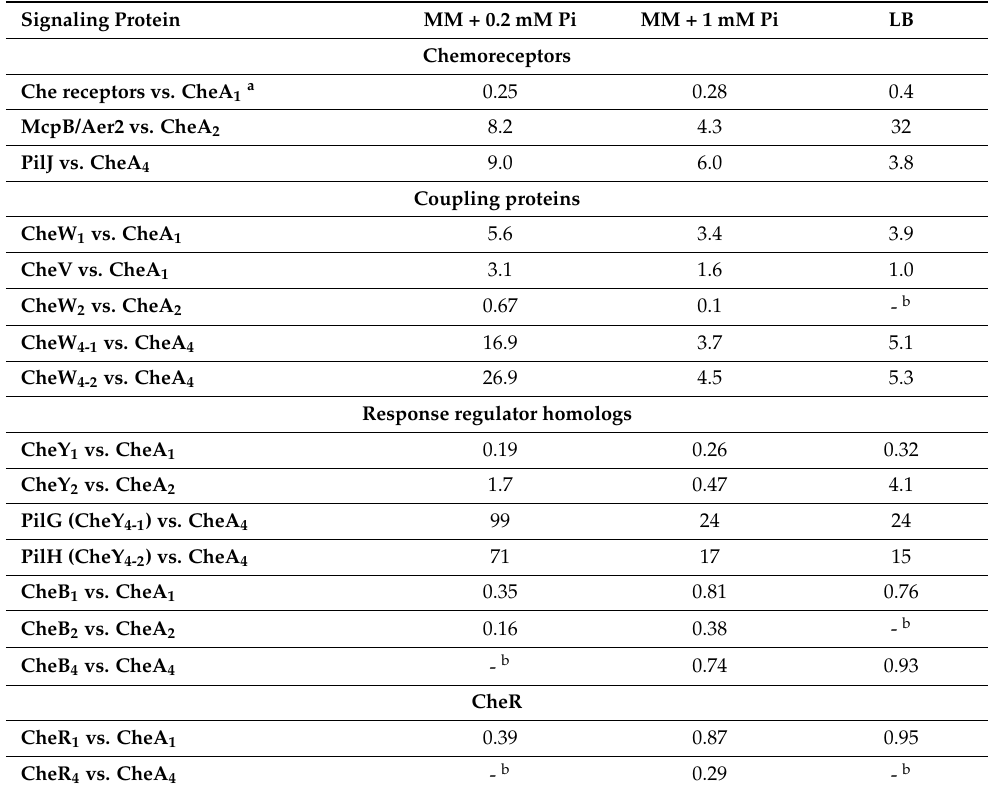
Table 3. Ratios of chemoreceptors and signaling proteins to CheA orthologues in different growth